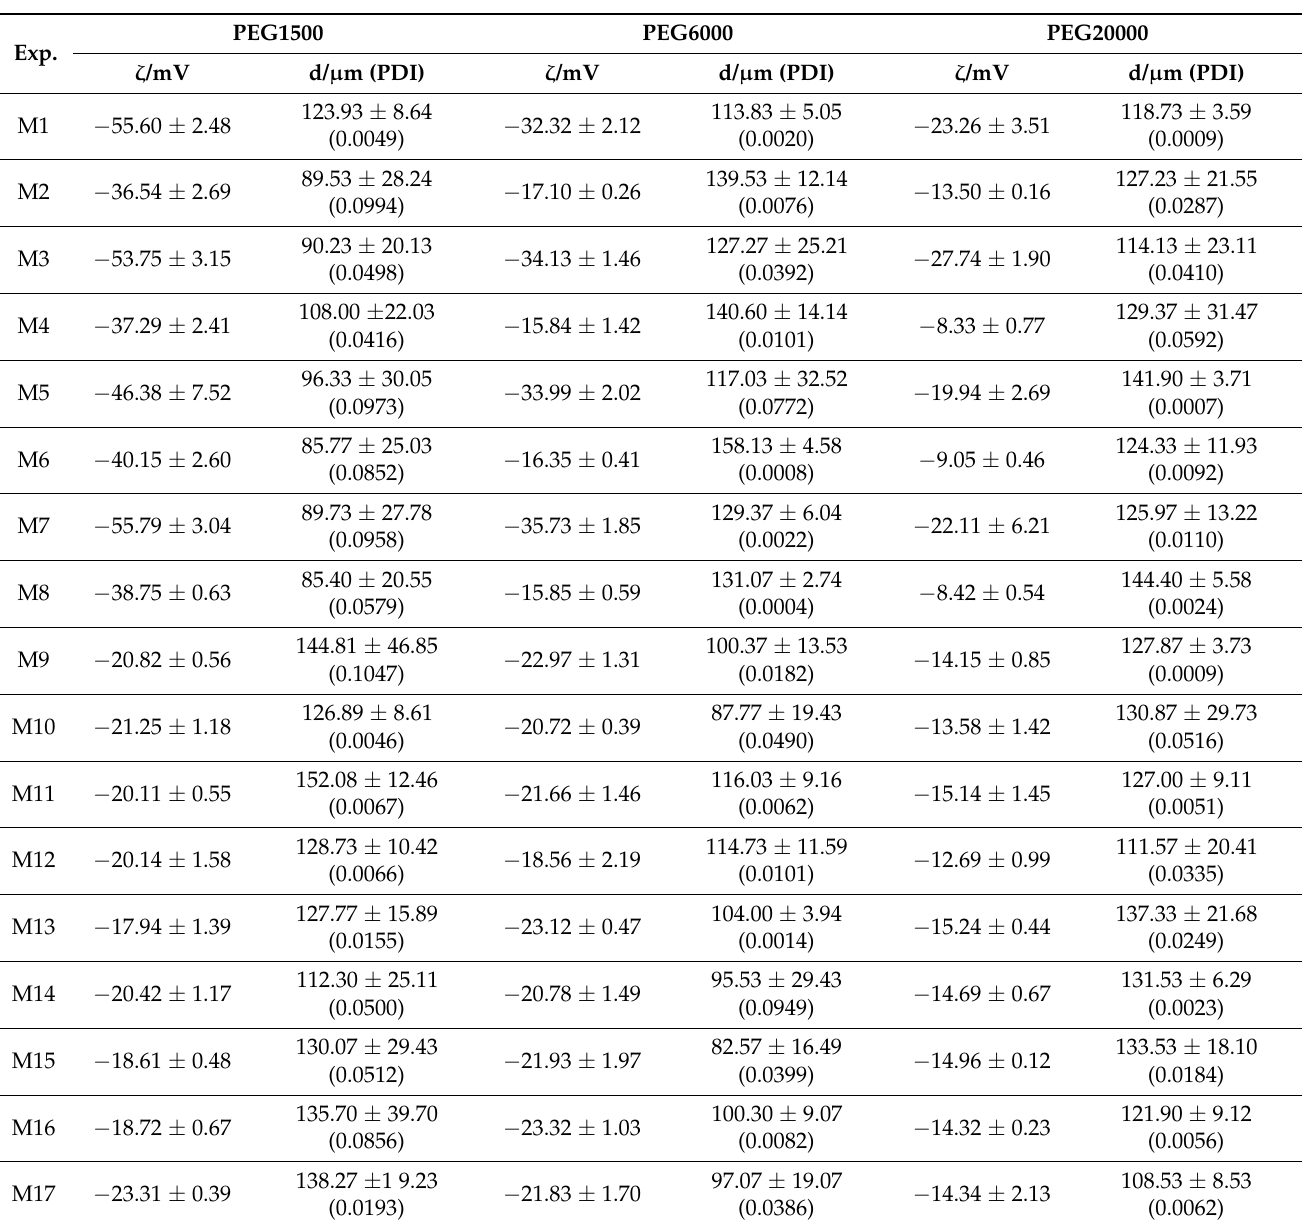
Table 4. Mean values of zeta potential and the average Feret diameter ( n = 3) of the oil-in-water emul- sion droplets prepared in continually operated microfluidic system using three different emulsifiers (PEG1500, PEG6000 and PEG20000). Polydispersity index (PDI) for the given droplet diameter is listed in the